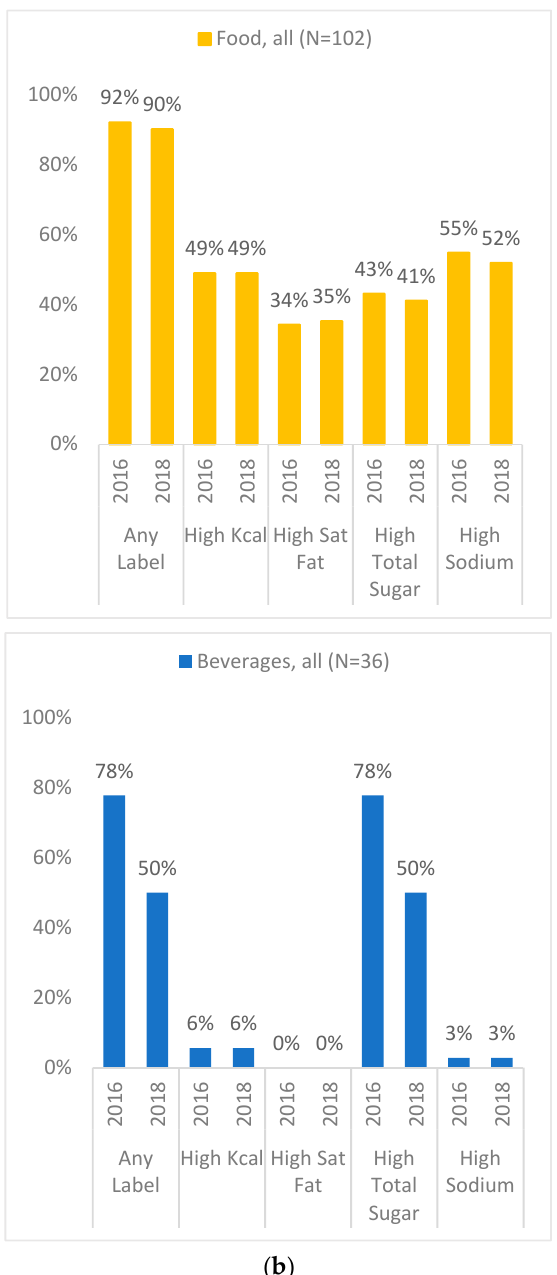
Figure 1. ( a ) Products that would be regulated under the Pan American Health Organization (PAHO) nutrient profile model by year. Trans fat is not included in this figure as there was no change between 2016 and 2018. Non-nutritive sweeteners (NNS) are sugar substitutes which contain few or no calories. ( b ) Products that would be regulated based on the nutrient profile model used in the Chilean Law of Food Labeling and Advertising by year.